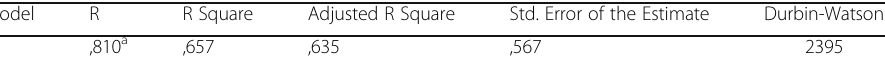
Table 21 Model Summary (R4) b